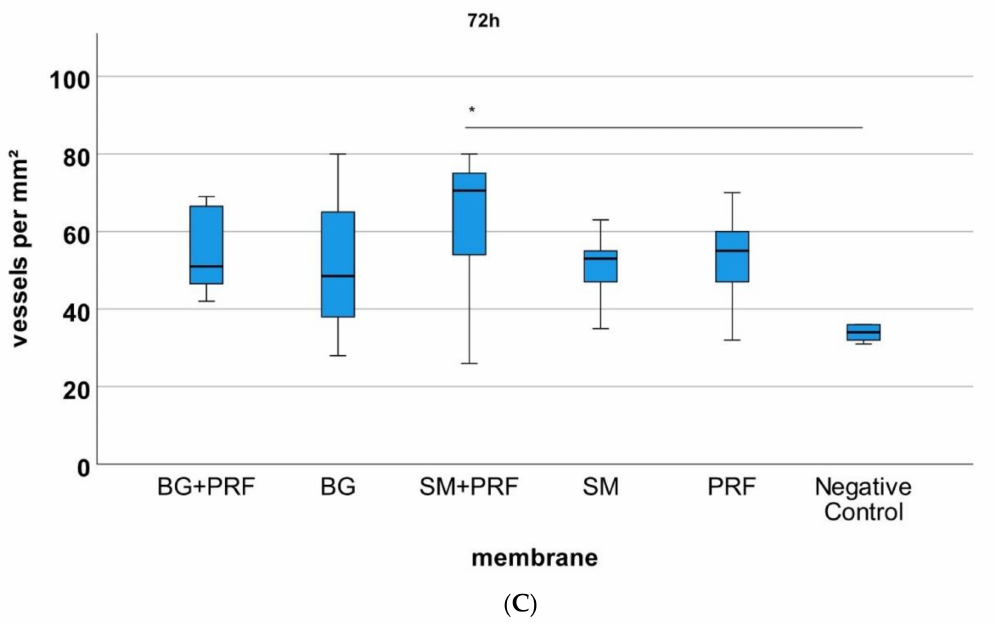
Figure 5. YSM assay and analysis of the vessels per mm 2 for the respective matrix (BG + PRF: Bio- Gide ® with PRF, BG: native Bio-Gide ® , SM + PRF: Symbios ® with PRF, SM: native Symbios ® ), PRF negative control. ( A ) 24 h, ( B ) 48 h, ( C ) 72 h of incubation. * marks statistically significant differences ( p < 0.05; for details, please see the responding paragraph).